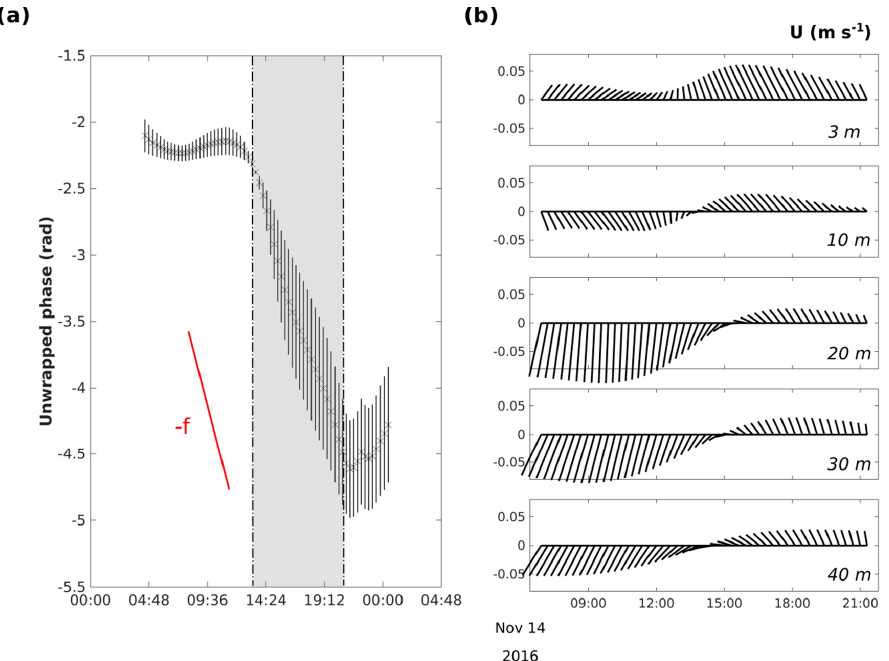
Figure 10. ( a ) Phase unwrapping of the horizontal current shear (3–40 m) from 14–15 November 2016. The negative slope corresponding to the Coriolis factor (-f) is shown. The shaded area corresponds to the portion of the period during which inertial oscillations are observed. ( b ) Horizontal currents from 14–15 November 2016, at 3, 10, 20, 30, and 40 m depth. All of these profiles show a clockwise oscillation of the currents.